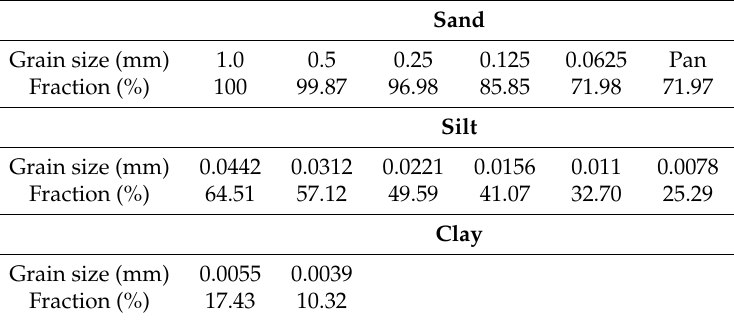
Table 2. Mean representative size classes of SSC.